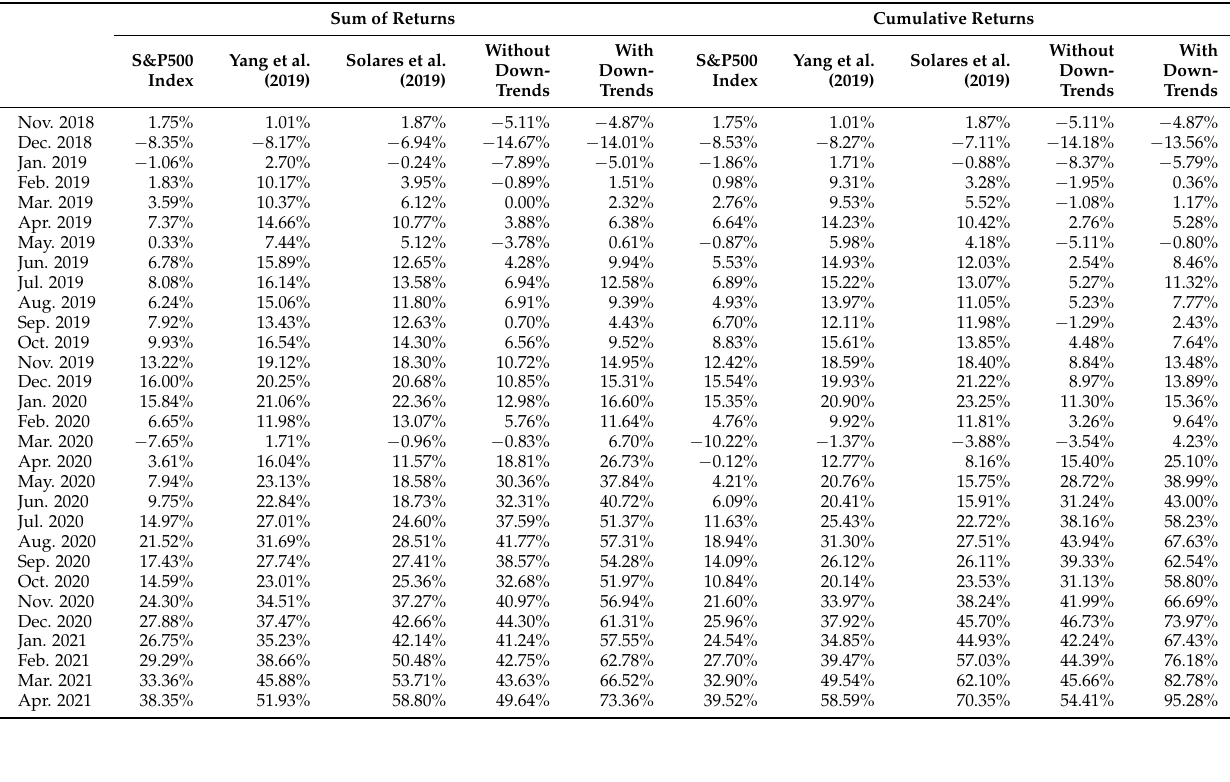
Table 2. Sum of returns and cumulative returns. In the case of the algorithms, the return is averaged over twenty runs.